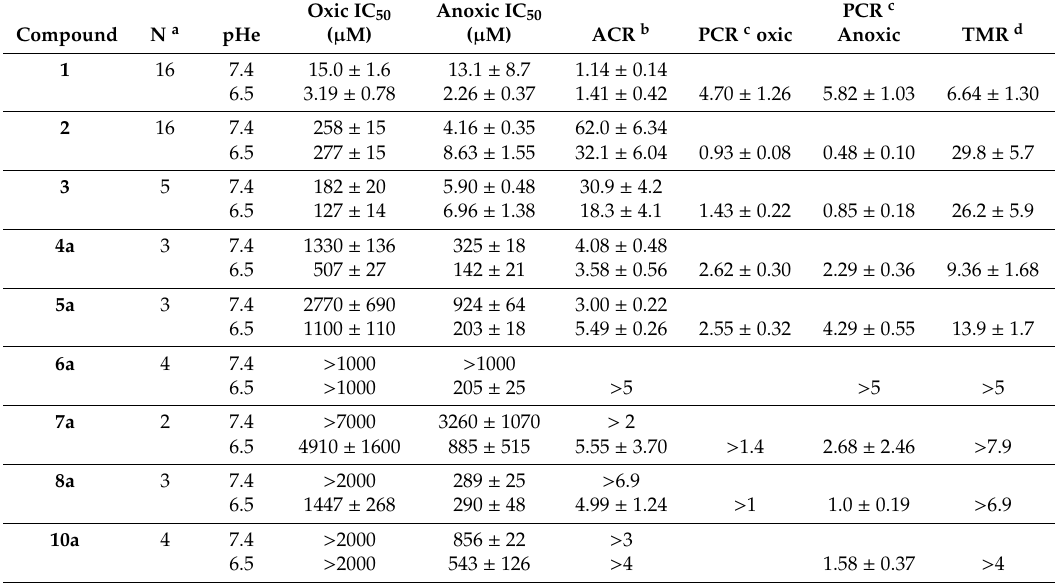
Table 4. Cytotoxicity of BTO acids and reference compounds against FaDu cells by IC 50 assay after 4 h exposure at pHe 7.4 or 6.5 under oxic or anoxic